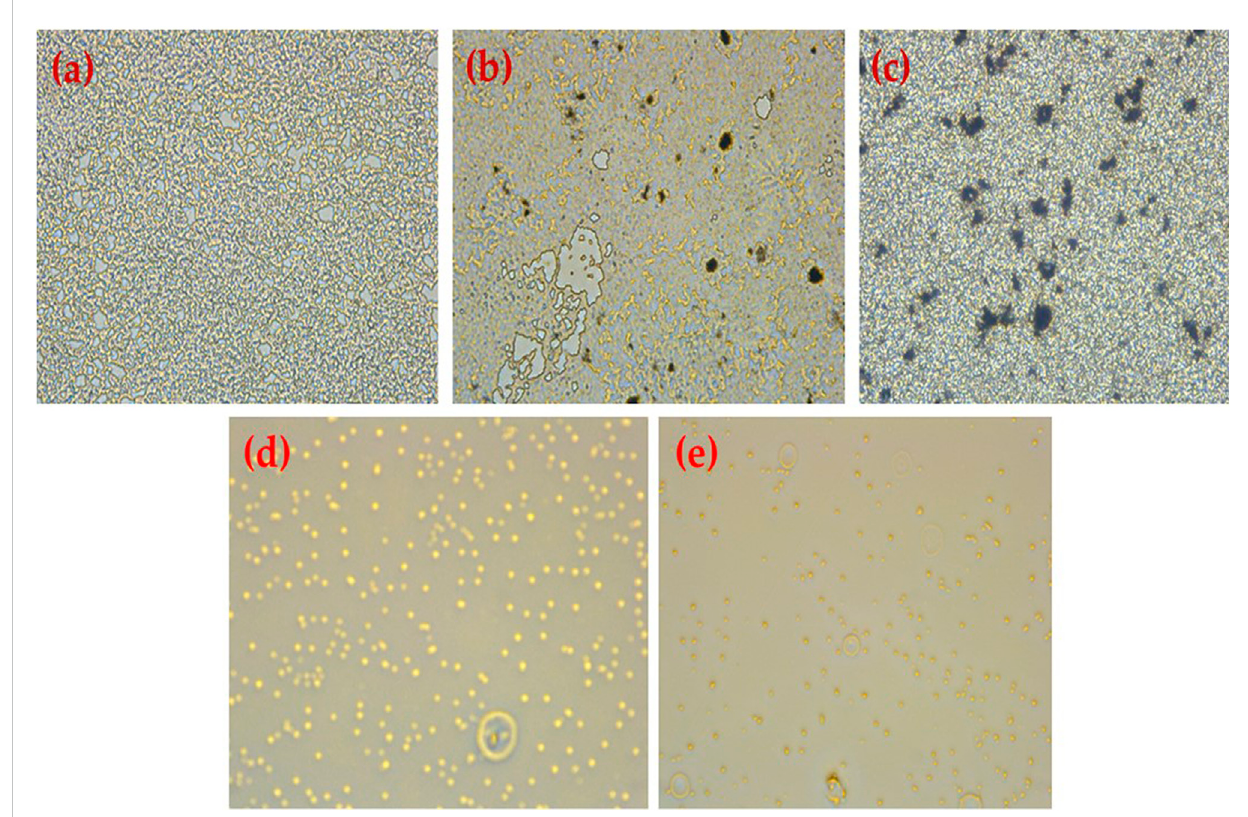
FIGURE 9 Resultsobtainedusinganinvertedmicroscope(40) (A) untreatedMRSAbio fi lm, (B) MRSAtreatedwithHRG100(µg/mL), (C) MRSAtreatedwithHRG